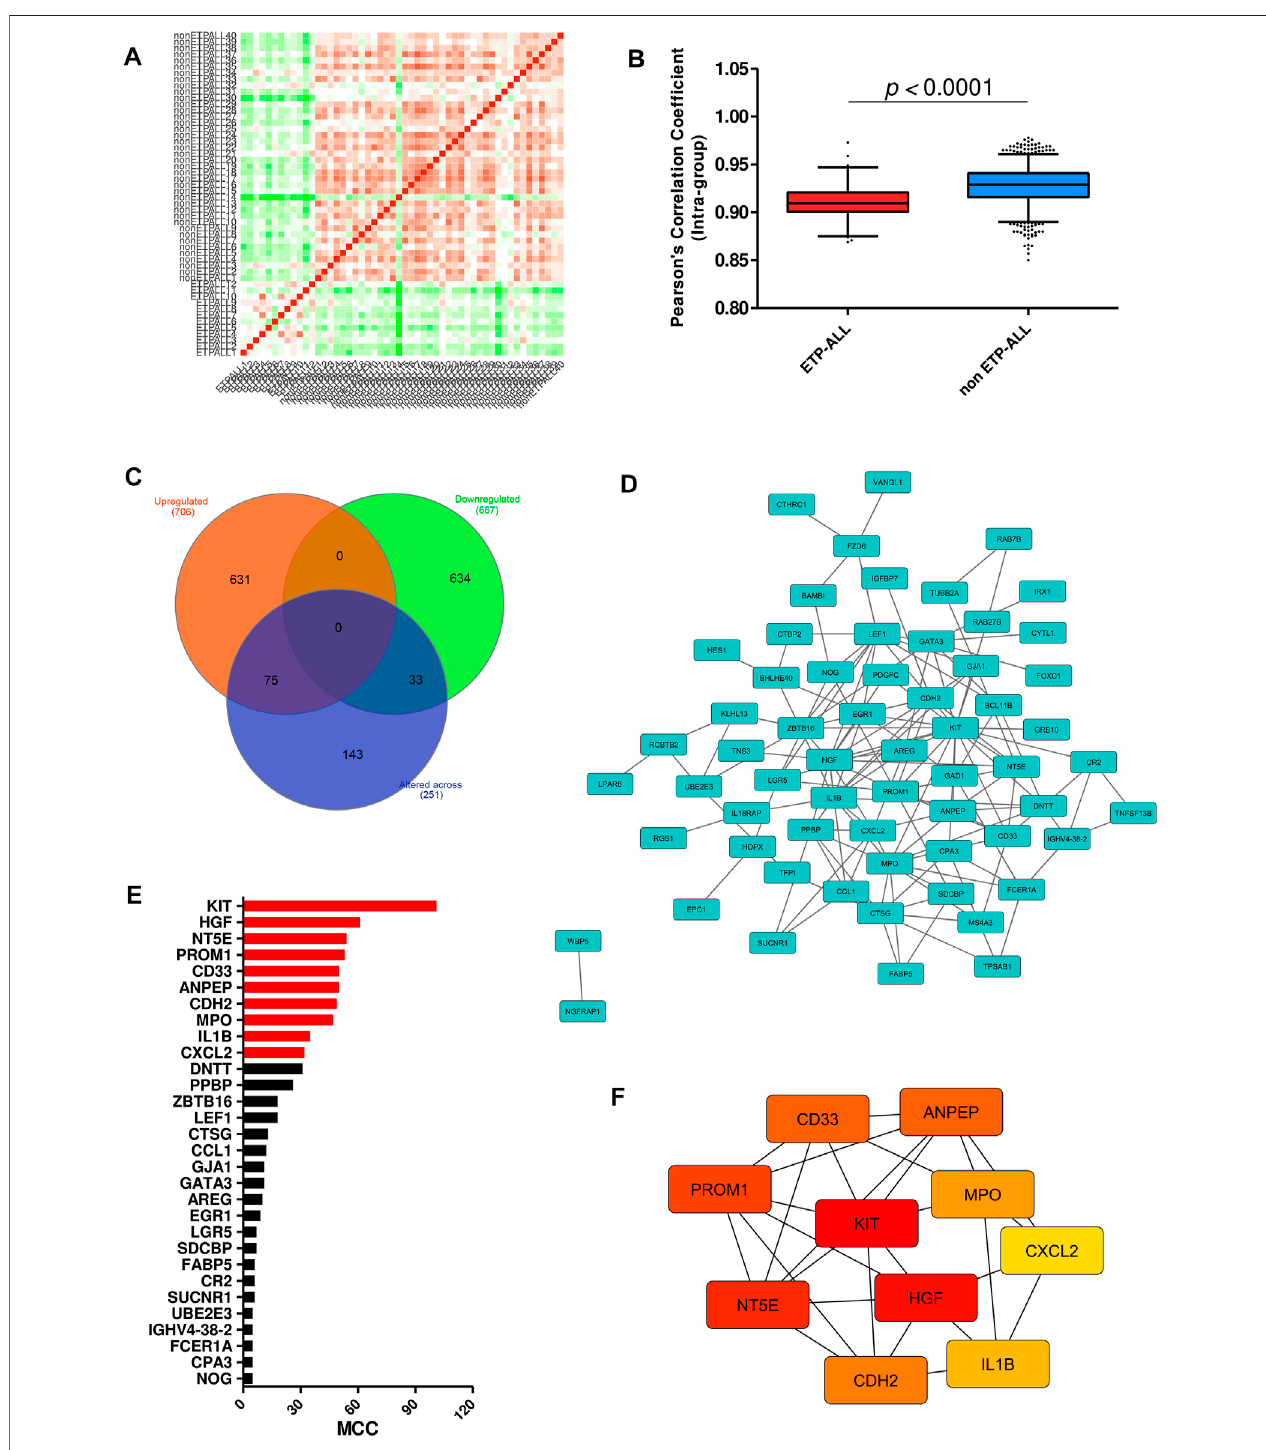
FIGURE 3 | Transcriptomic variability within the ETP-ALL group. (A) Pair-wise correlation matrix of global gene expression levels between each sample from GSE28703. (B) Box-plot of intra-group Pearson ’ s correlation coef fi cients in ETP-ALL and non-ETP-ALL groups. Statistical signi fi cance was calculated using two-tailed unpaired Student ’ s t-test. (C) Venn diagram of different sets of differentially expressed genes. Tangerine, green and purple circles represent genes upregulated in, downregulatedinand altered (standard deviation > 2)acrossETP-ALL,respectively. (D) Functionalprotein-proteininteractionnetworkofgenesup/downregulated in aswellasaltered acrossETP-ALL. Constructed on Cytoscape v3.8.2. (E) Maximal Clique Centrality (MCC) scoreoftop 30hubnodesfromthe networkin Figure 3D . Top 10 hub nodes are labelled in red. (F) Shortest interaction path of top 10 hub genes within the network. Constructed on Cytoscape v3.8.2.